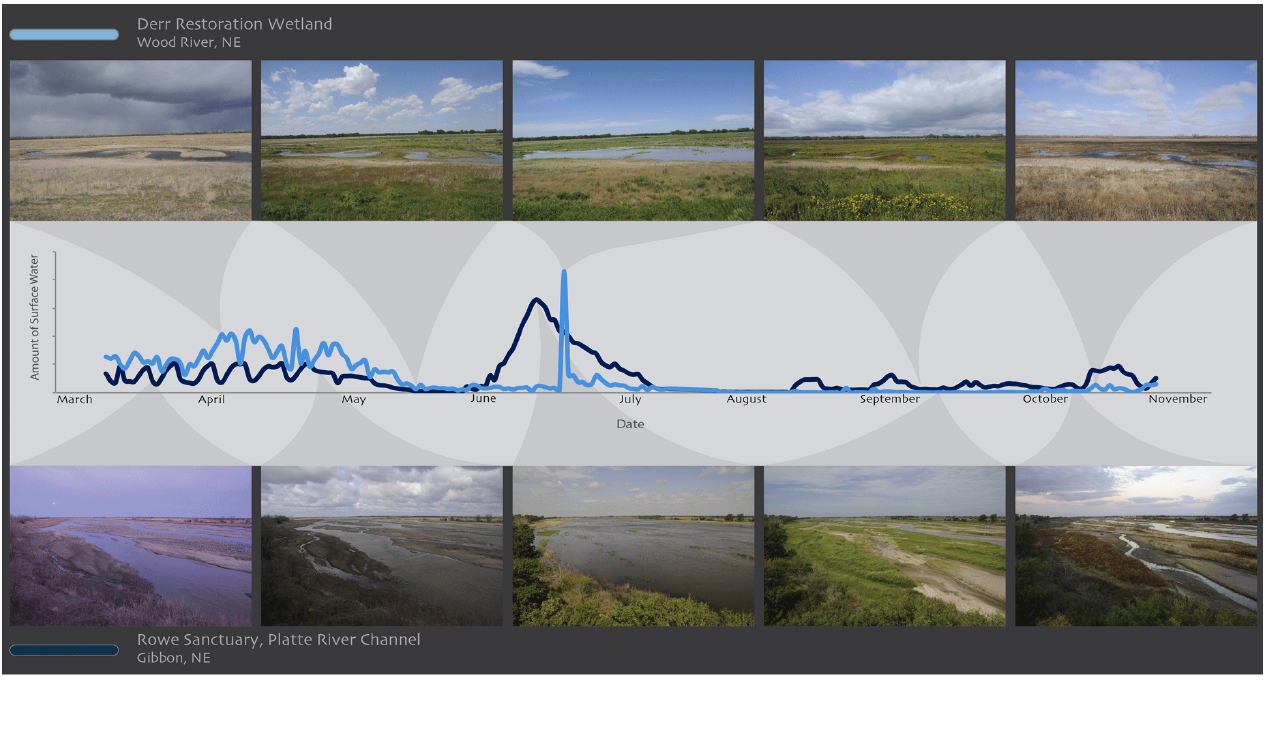
Fig. 4 . Hydrograph of streamflow at Rowe River Channel (RRC) and water inundation data at Derr Restoration Wetland (DRW). Streamflow data at RRC was acquired from U.S. Geological Survey stream gauge data, whereas water inundation at DRW is data resulting from image analysis of time-lapse